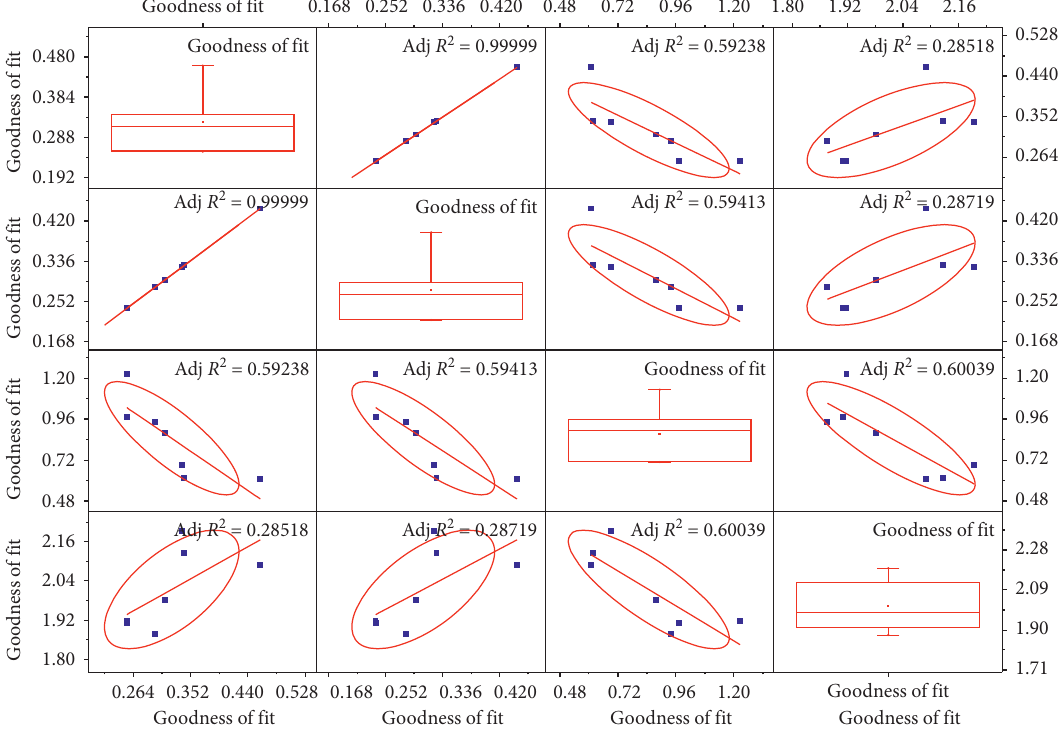
Figure 6: Summary of dynamic evaluation regression model overall test